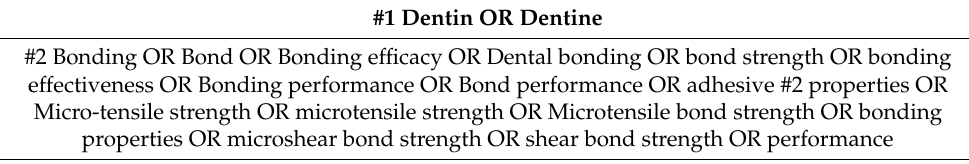
Table 1. Search strategy used in PubMed.